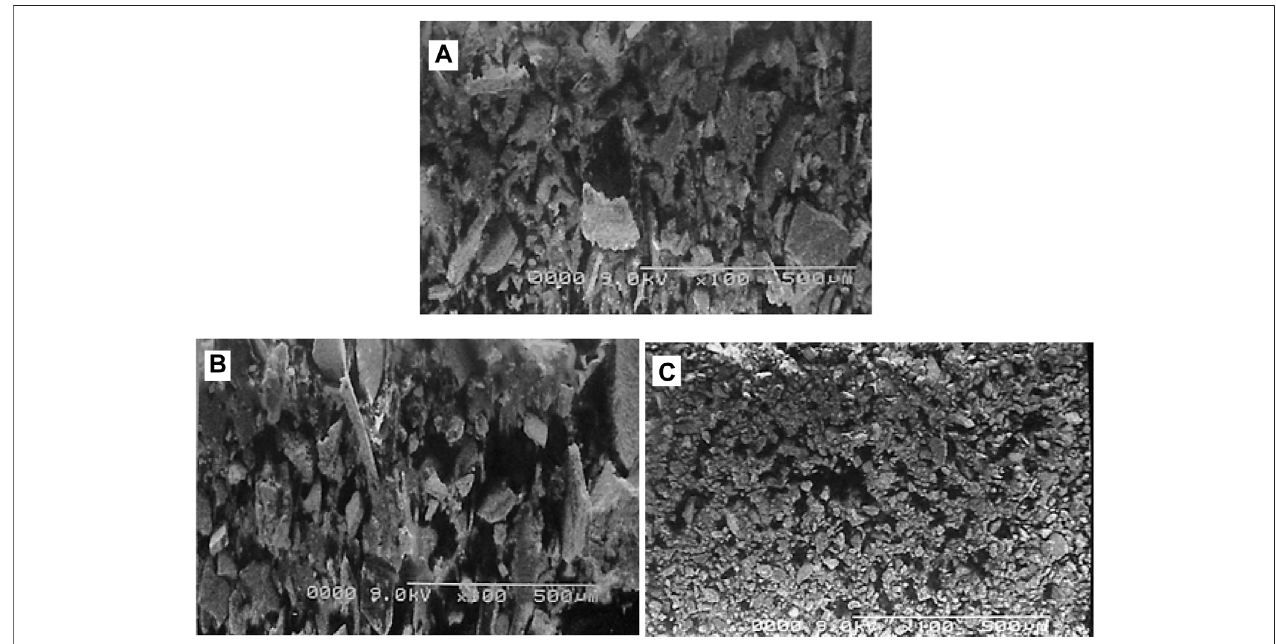
FIGURE 6 | SEM images of (A) POC (pure), (B) POC/MMT (5%), and (C) POC/MMT (10%).